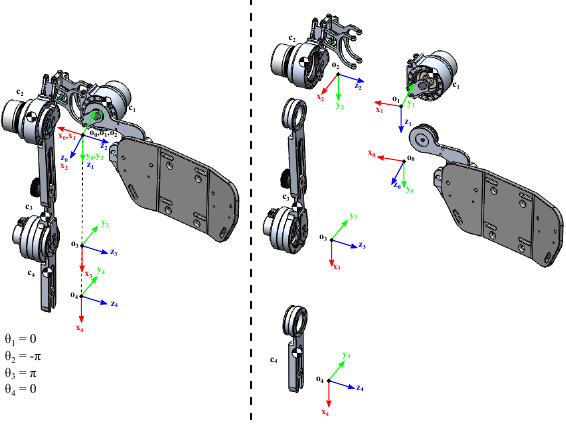
Figure 3: The coordinate systems of the